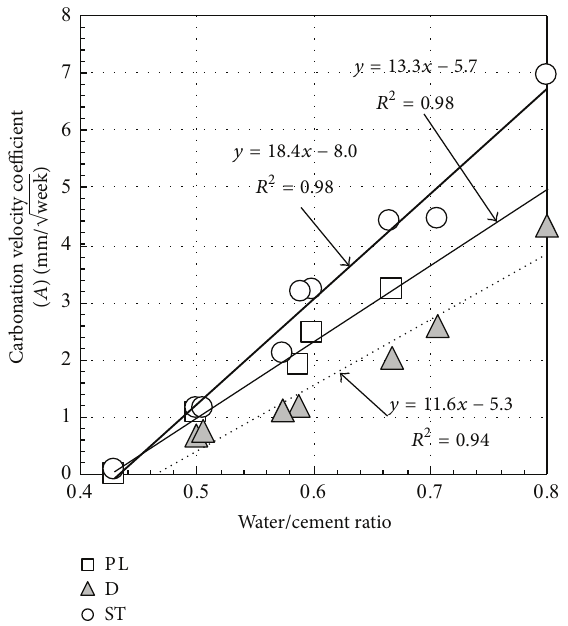
Figure 11: Relation between air content after hardening and dura- bility